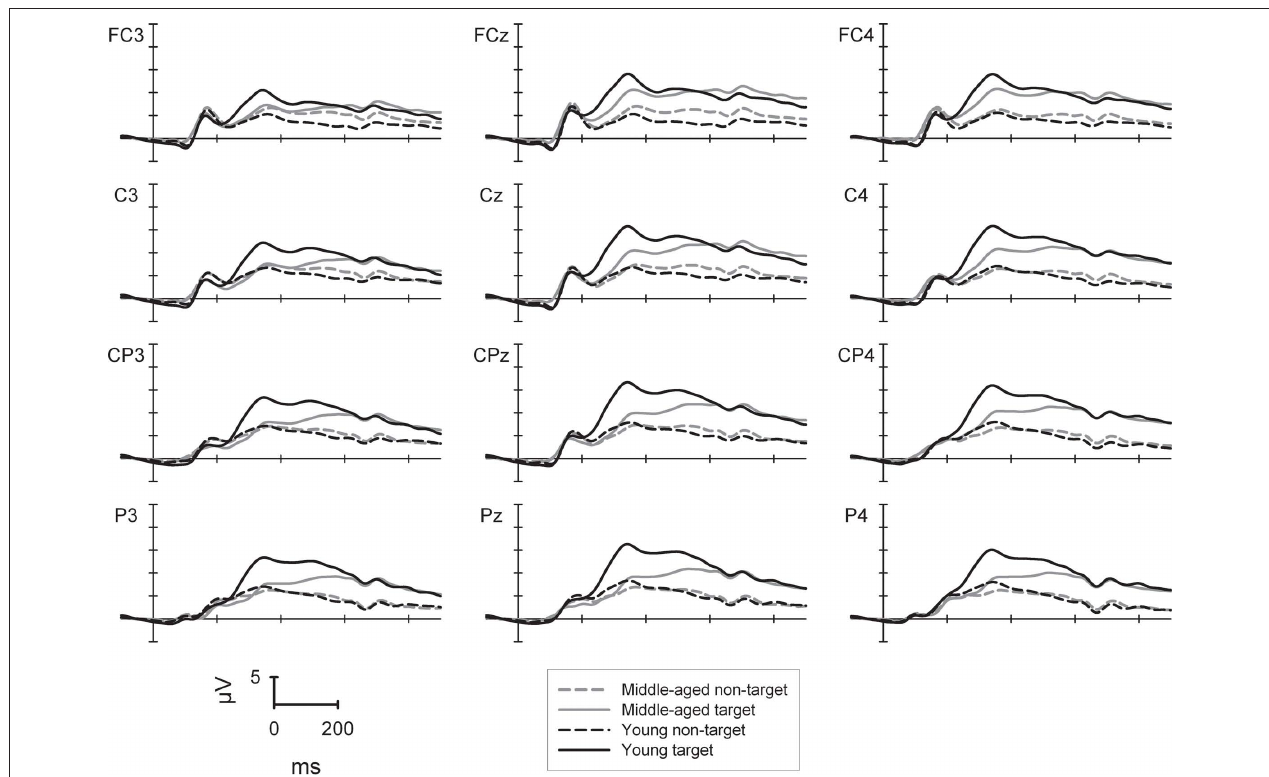
Figure 2 | P300 potential at selected electrode sites for the 2-back task (high working memory load) separately for the young (black lines) and middle- aged group (gray lines) as well to target (solid lines) and non-target stimuli (dashed